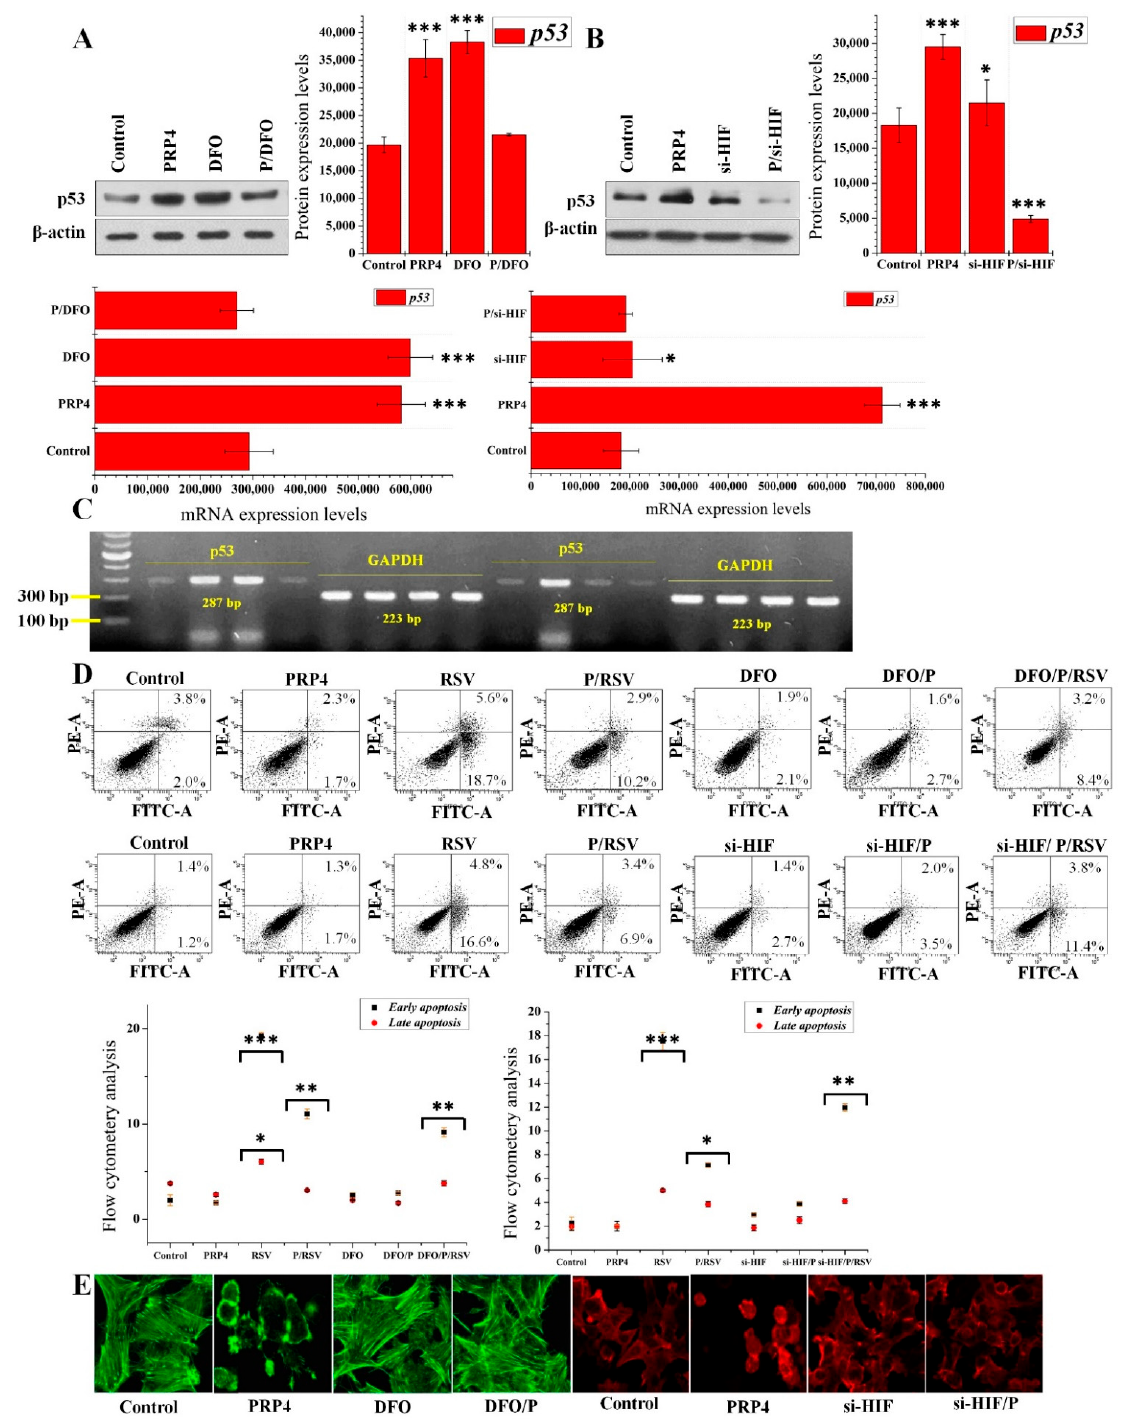
Figure 6. PRP4 action is mediated through the activation of HIF-1 α and miR-210. Protein and mRNA levels of p53 in untransfected, PRP4-transfected, HIF-1 α -mimetic-induced, and HIF-1 α -silenced HCT116 cells were analyzed by ( A , B ) Western blot and ( C ) RT-PCR, with actin and GAPDH used as loading controls for Western blots and RT-PCR, respectively. * p < 0.05, *** p < 0.001. DFO, treatment with deferoxamine; P/DFO, treatment with deferoxamine and transfection with PRP4; si-HIF, transfection of siRNA-HIF 1 α ; P/si-HIF, transfection with PRP4 and siRNA-HIF 1 α ; DFO/P/RSV, treatment with deferoxamine and resveratrol and transfection with PRP4; si- HIF/P/RSV, transfection with si-RNA HIF 1 α and si-RNA PRP4, and treatment with resveratrol; ( D ) the upper panel represents an annexin-V/PI apoptosis assay documenting the regulatory